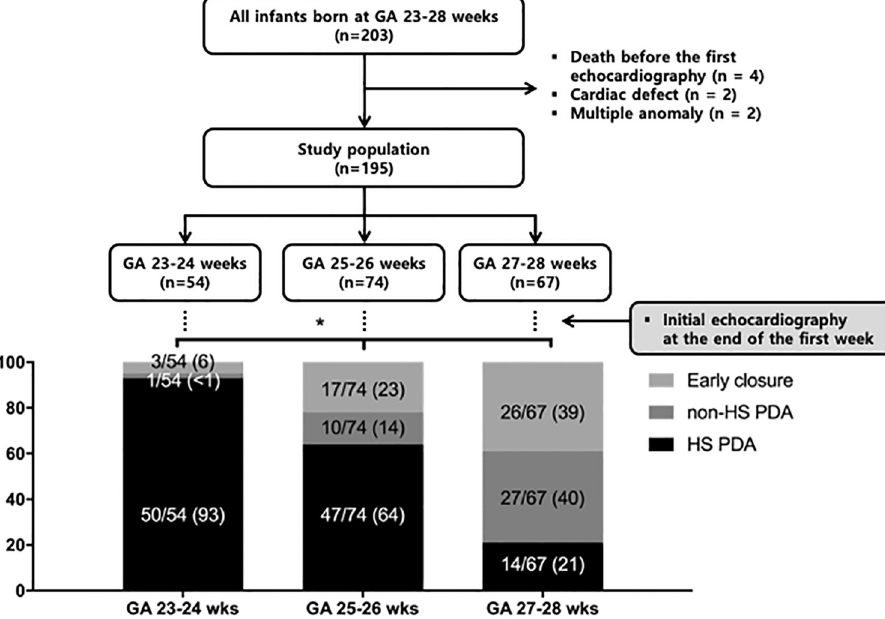
Fig 1. Initial incidence of HS-PDA, HIS-PDA, and early closure at the end of the first postnatal week according to gestational age subgroup. GA, gestational age; HS-PDA, hemodynamically significant patent ductus arteriosus; HIS-PDA, hemodynamically insignificant patent ductus